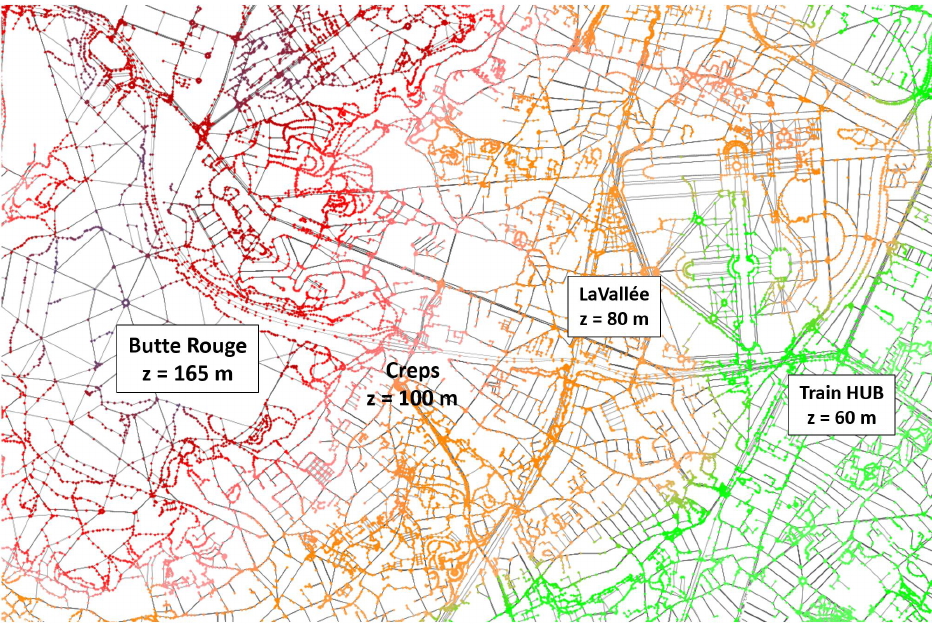
Figure 2. Altitudes from sea level. The city spreads over an area with three main plateau. The train station is the main hub of the area to get to Paris, while LaVallée and Butte Rouge are two important bases of